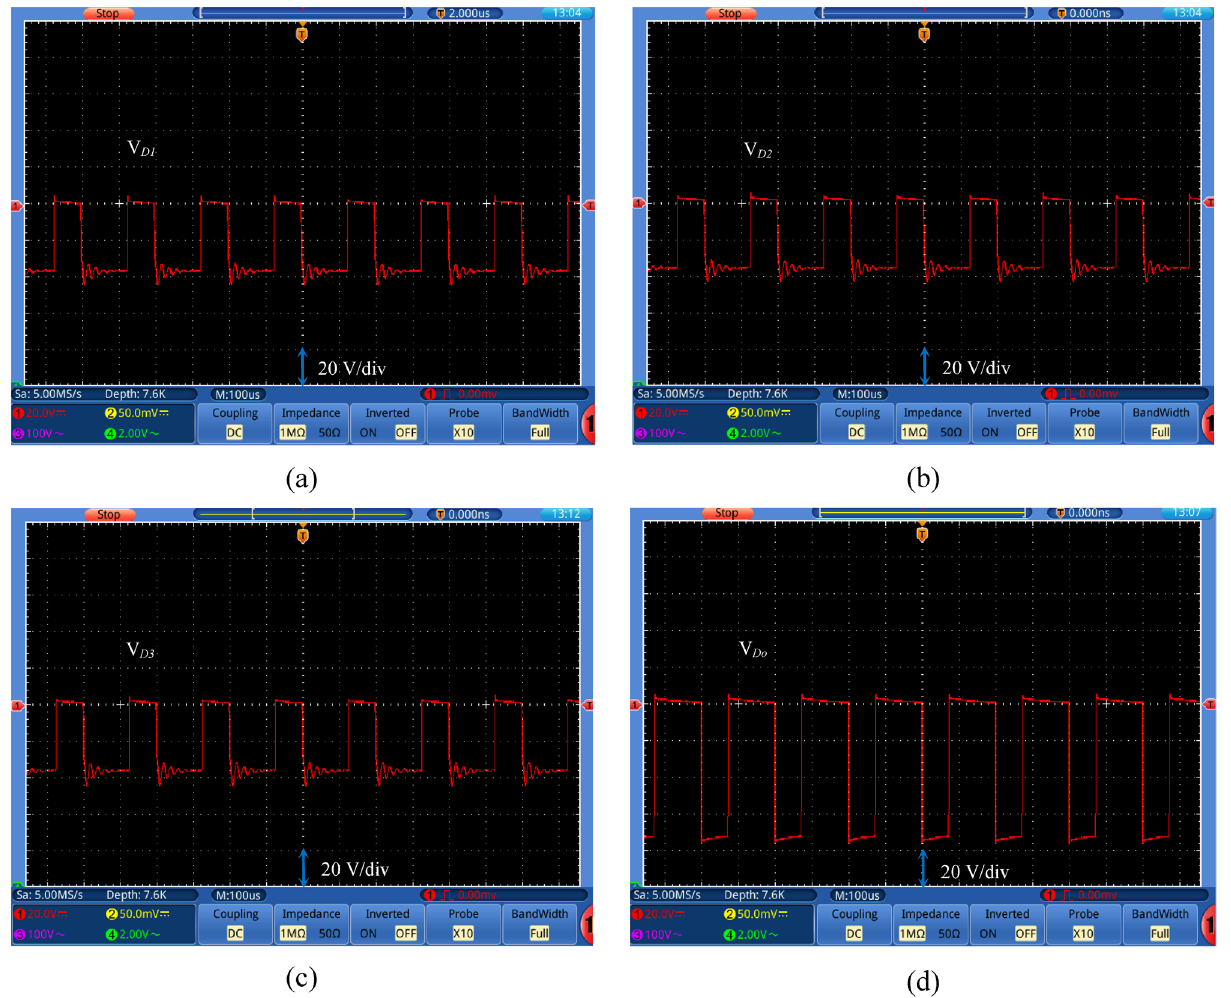
Figure 12. Experimental waveforms of ( a ) diode D 1 voltage, ( b ) diode D 2 voltage, ( c ) diode D 3 voltage, and ( d ) diode D